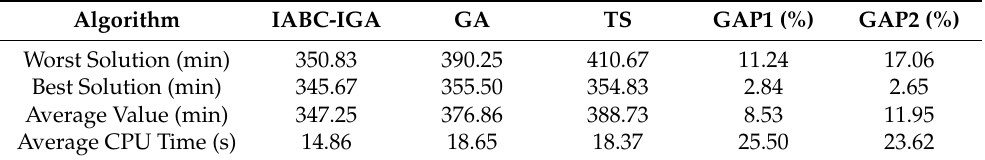
Table 6. Comparison of algorithms.